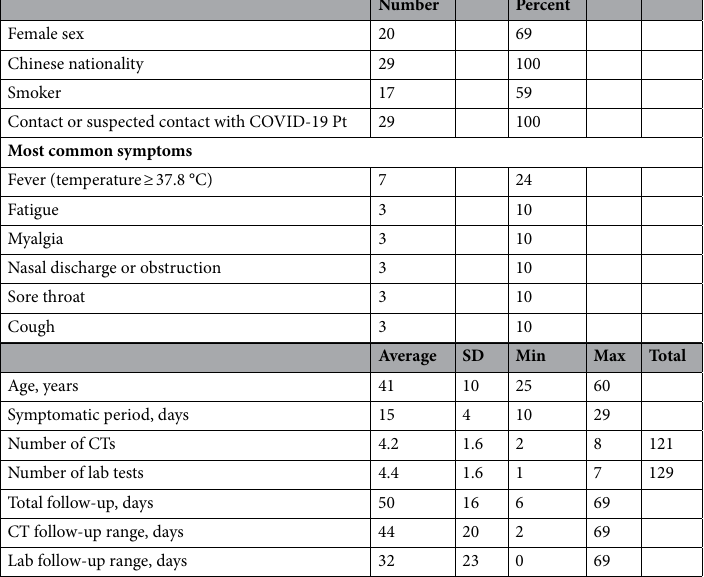
Table 4. Demographic data and follow-up periods for patients with sequential CTs and